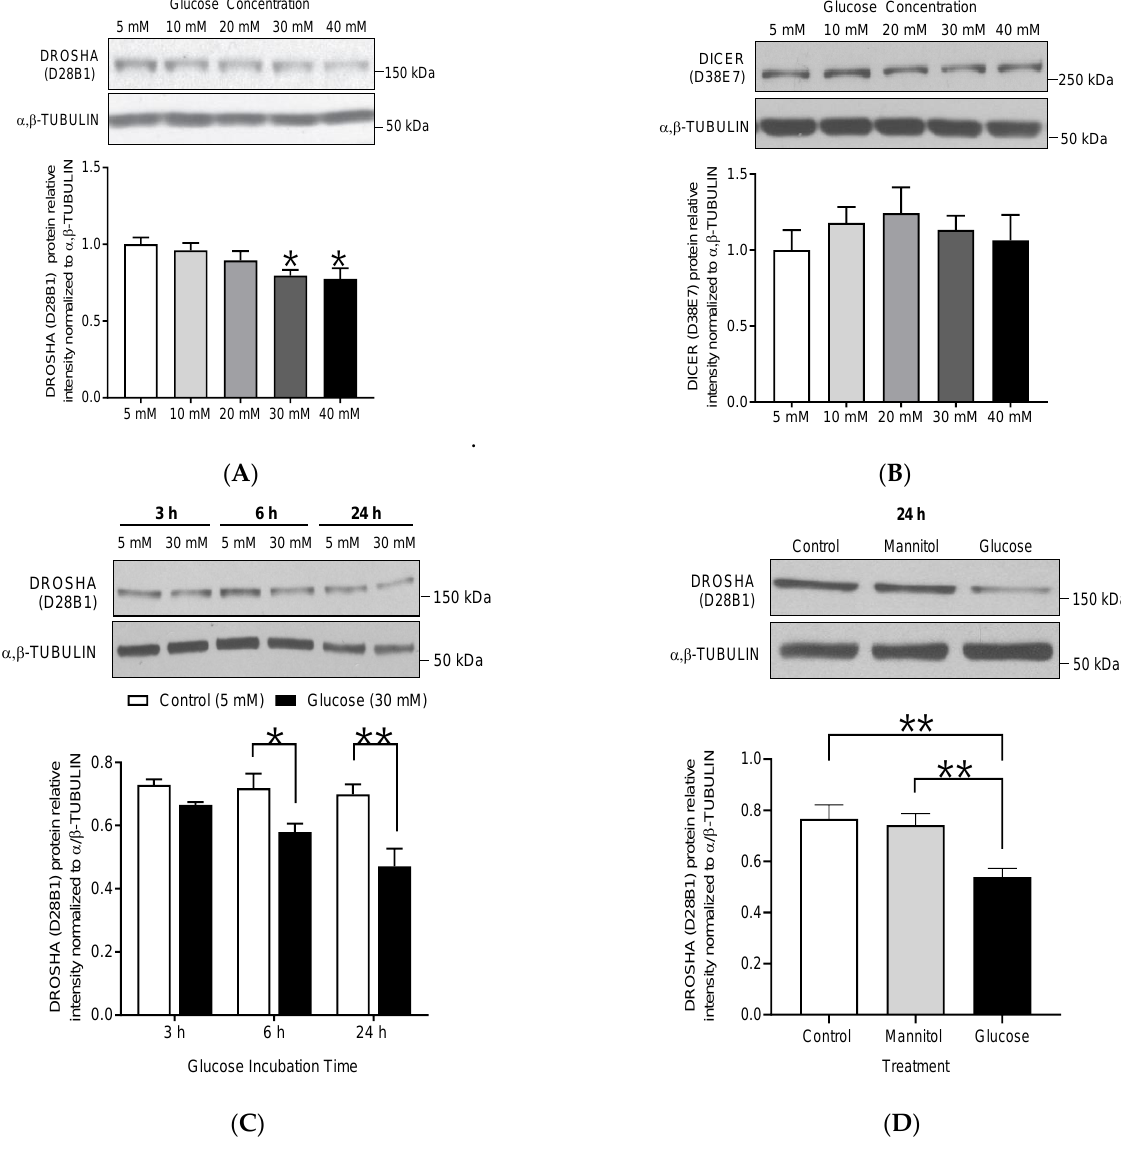
Figure 2. Dose and time effect of glucose treatment on DROSHA protein expression in human primary dermal microvascular